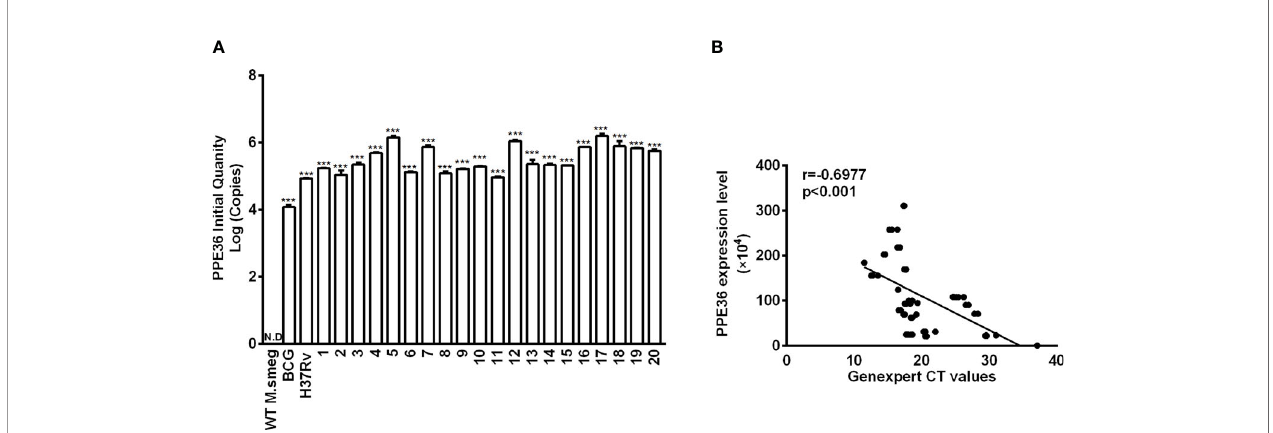
FIGURE 1 | PPE36 expression was predominantly enriched in the virulent mycobacteria. (A) PPE36 expression in WT M. smeg , BCG, H37Rv, and clinical isolates (n = 20) was quanti fi ed by real-time PCR assays. N.D, no detection. (B) Correlation of PPE36 expression in clinical isolates with the bacterial loads in clinical samples. ***p <0.001.